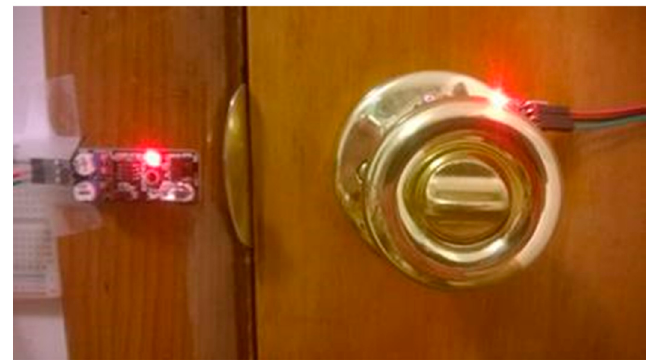
Figure 4. The prototype of the lock checker. The obstacle avoidance sensor is attached to the door frame, and the touch sensor is attached on the door handle.